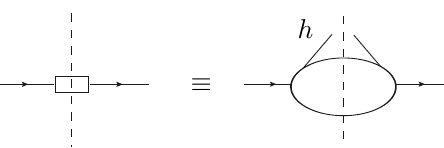
Figure 2 . Graphical convention for the fragmentation function of a parton (here a quark for illustration) to a hadron h plus spectators. In the rest of this article, we will use the left-hand side of this drawing.